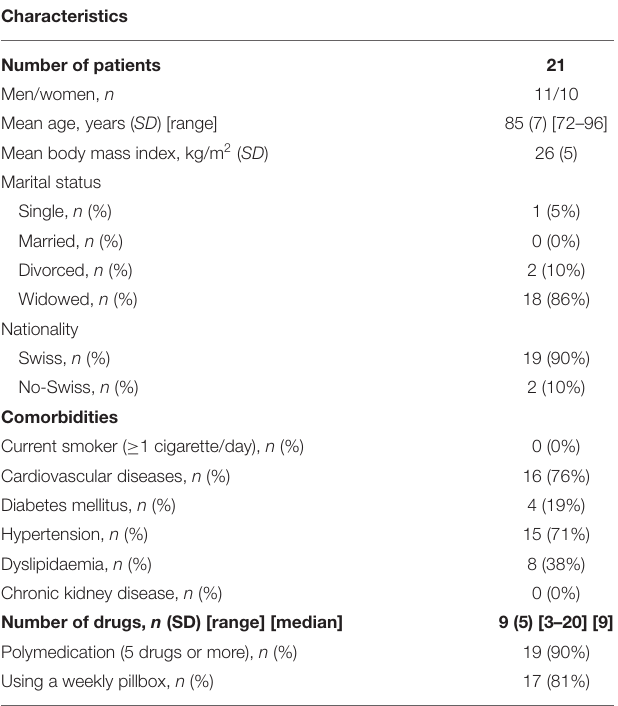
TABLE 1 | Baseline characteristics of included older adults. Characteristics